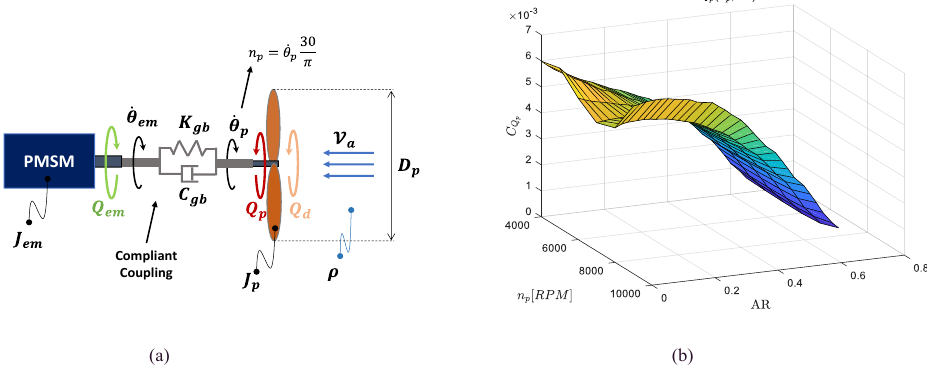
Figure 3. Fully electric propulsion system for UAV: ( a ) mechanical schematics and ( b ) nondimensional torque coefficient as function of propeller angular speed and advance ratio (APC 22x10E [29]).